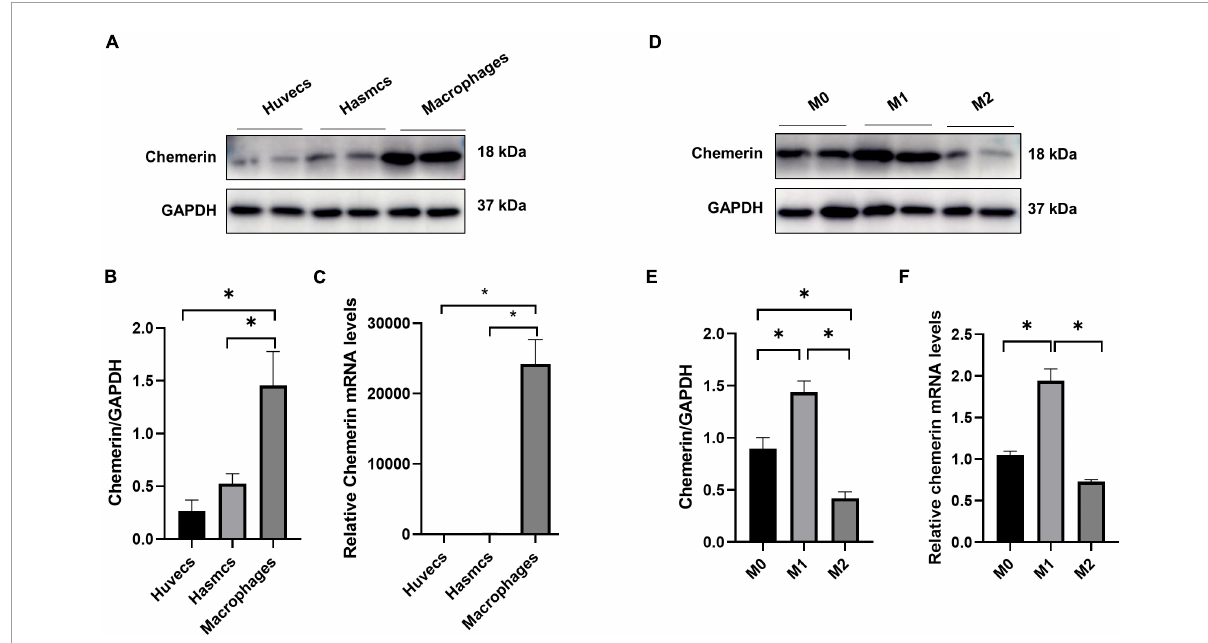
FIGURE4 High expression of chemerin in M1 macrophages. (A–C) Chemerin mRNA and protein levels were higher in macrophages than in HASMCs and HUVECs. (D–F) Higher chemerin mRNA and protein levels were displayed in M1 than in M2 macrophages. Statistically significant p -values were marked by * p < 0.05. HUVECs, human umbilical vein endothelial cells; HASMCs, human aortic smooth muscle